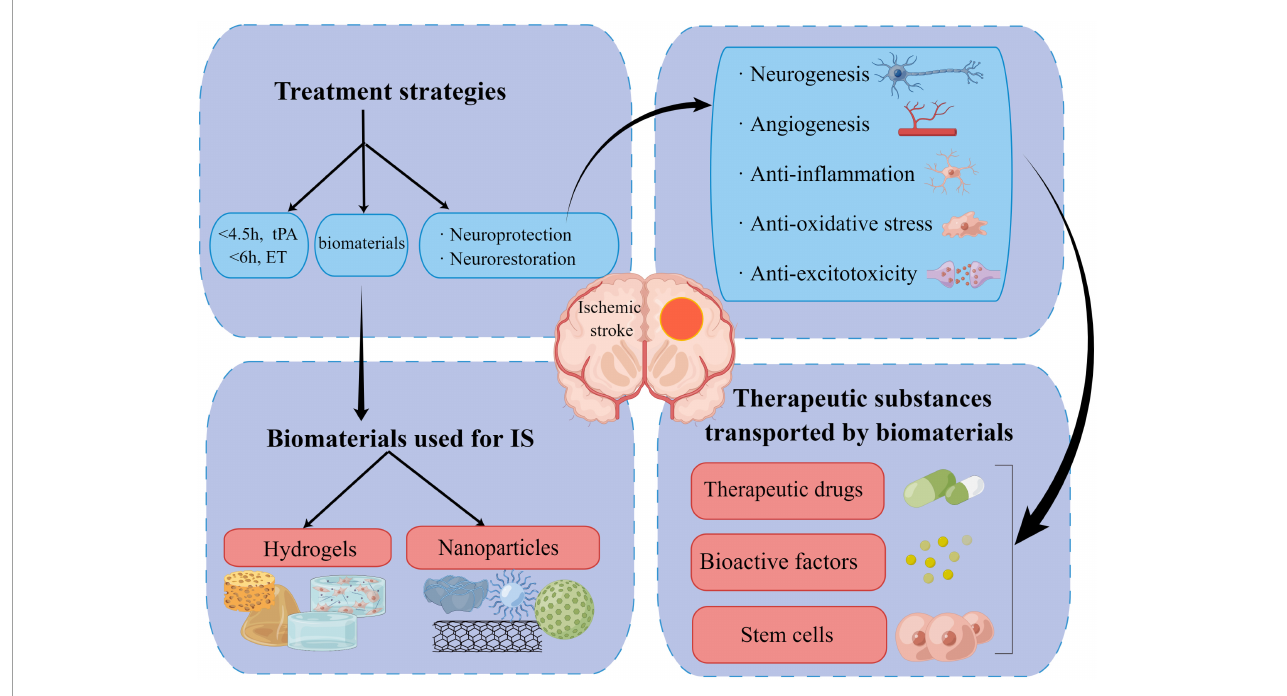
FIGURE2 Summary of current therapies, new biomaterials, and the underlying therapeutic mechanism for ischemic stroke (by